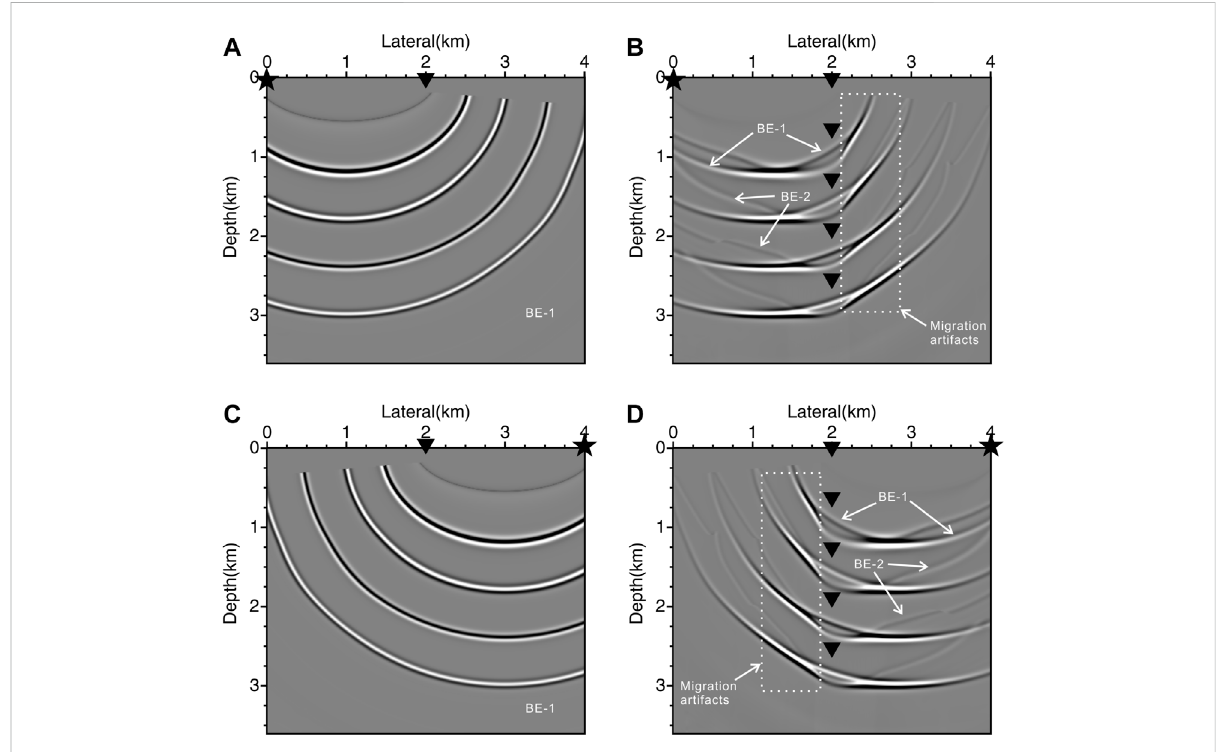
FIGURE 4 Theimagingresultsusing (A) thestartingtraceand (B) thetotaltracesoftheshotatpositionx=0 m; (C,D) arecorrespondingimagingresultsat position x = 4,000 m.